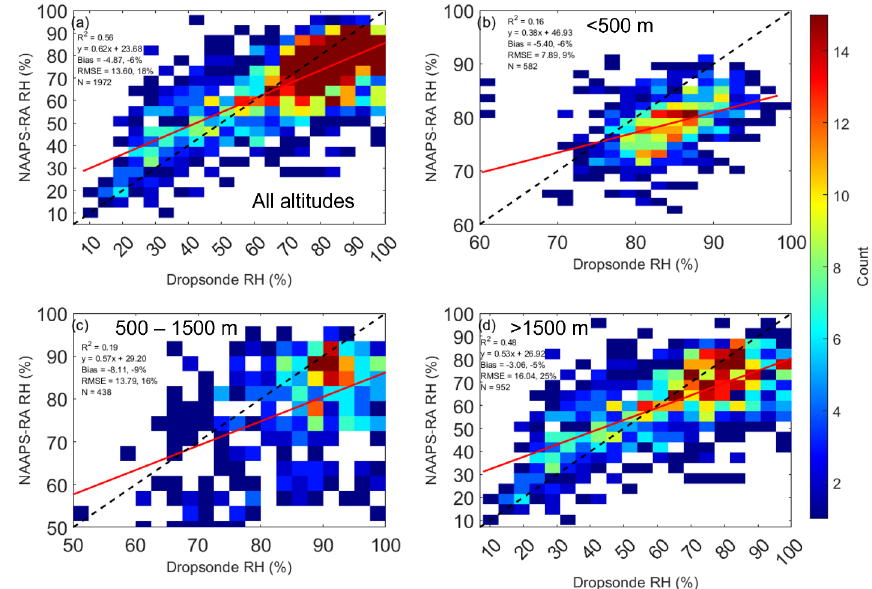
Figure 3. Comparison between simulated (NAAPS-RA) and measured (dropsonde) RH (a) for all altitudes, (b) below 500 m, (c) between 500–1500m, and (d) above 1500m. Linear fits are indicated with red lines, 1 : 1 lines are shown as dotted lines, and the color bar indicates the number of points falling in each bin. Where bias and RMSE are reported, the first and second numbers are the absolute and relative values,